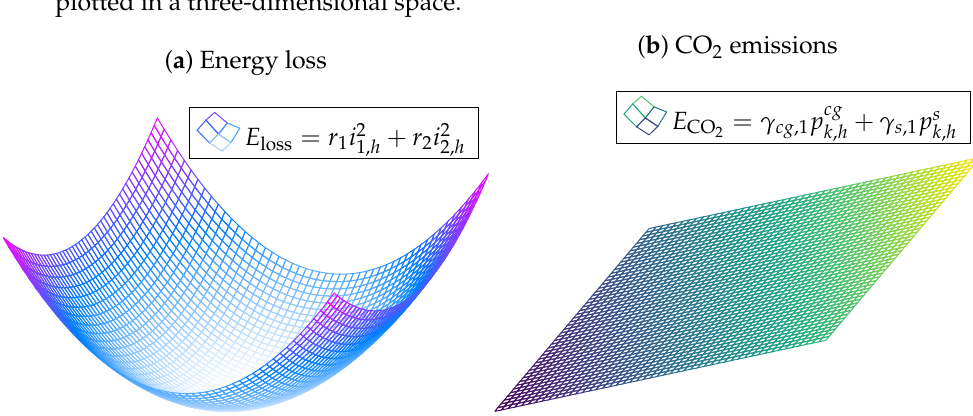
Figure 1. Convex structure of the objective functions: ( a ) hyper-paraboloid that represents the energy loss function in (1), and ( b ) plane that represents the emissions of CO 2 in